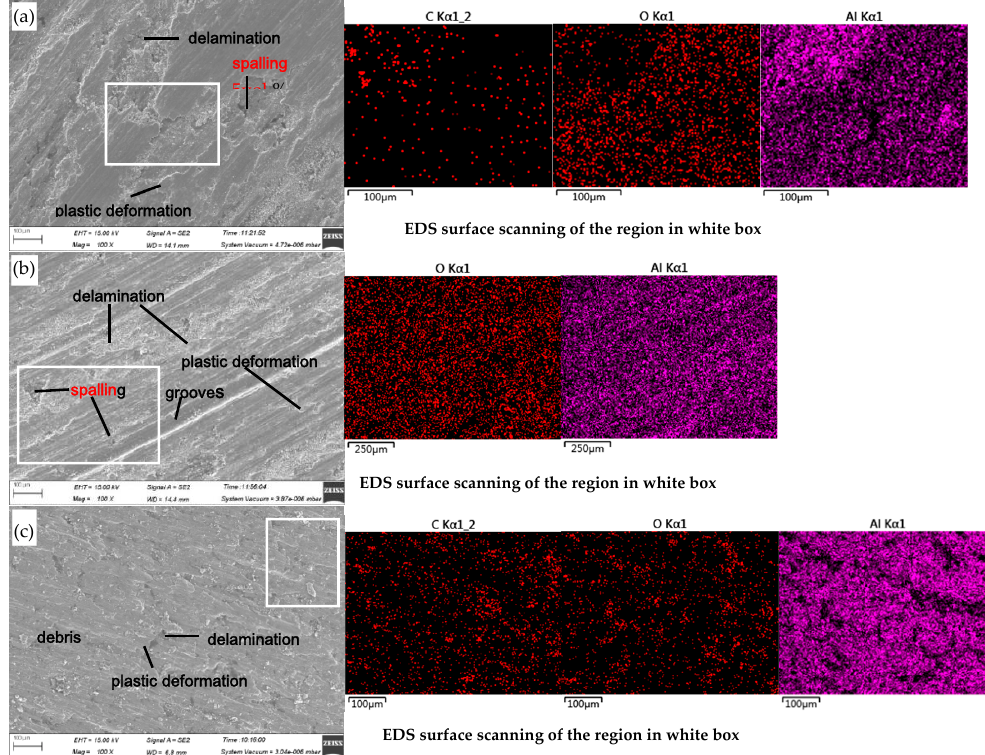
Figure 9. SEM micrographs and EDS surface scanning results of worn surfaces of the composites bearing 10 vol.% graphite sintered at ( a ) 5.2 GPa and 550 °C, ( b ) 5.2 GPa and 750 °C and ( c ) 35 MPa and 520 °C, respectively.